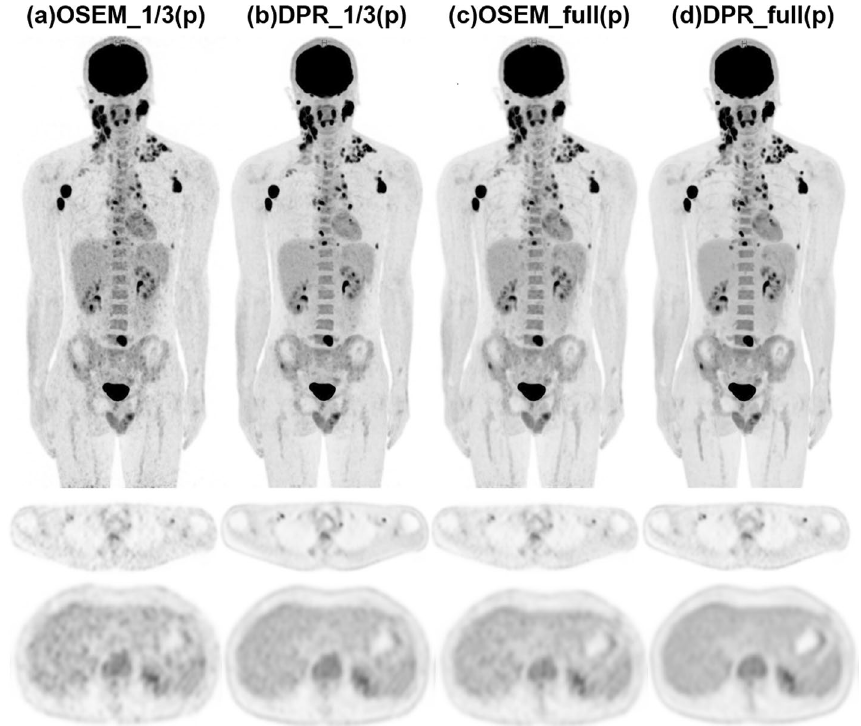
Fig. 4 PET images of a 31-year-old male patient diagnosed with Hodgkin’s lymphoma in the prospective study. After injection of 85 MBq 18 F-FDG, the patient underwent a PET scan with 6 min per bed position 77 min post-injection. To comprehensively compare the clinical images reconstructed by the two algorithms, we further reconstructed the data with 1/3 and full of the acquisition duration for OSEM and DPR algorithms. Both the MIP (upper row) and transverse images (middle row) demonstrated improved lesion detectability of the DPR images compared to the OSEM images with the same acquisition duration ( a – d ). The transverse image in the liver plane showed reduced image noise when comparing subfigures a – d , while the image noise in the subfigures b and c was at a comparable level